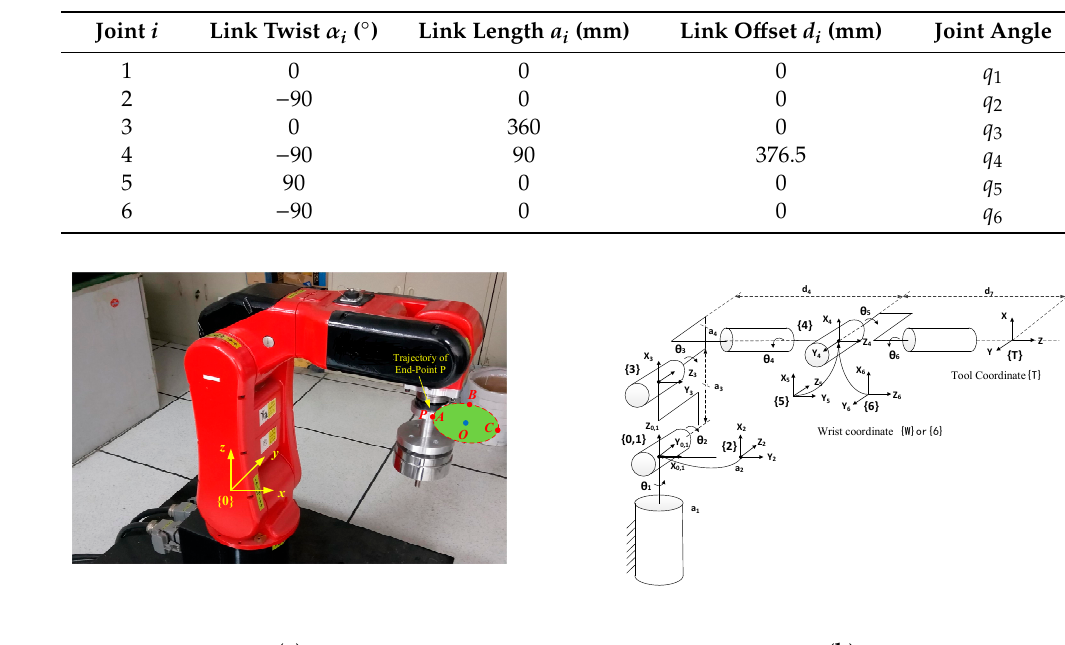
Table 1. Modified D-H parameters of Robot.